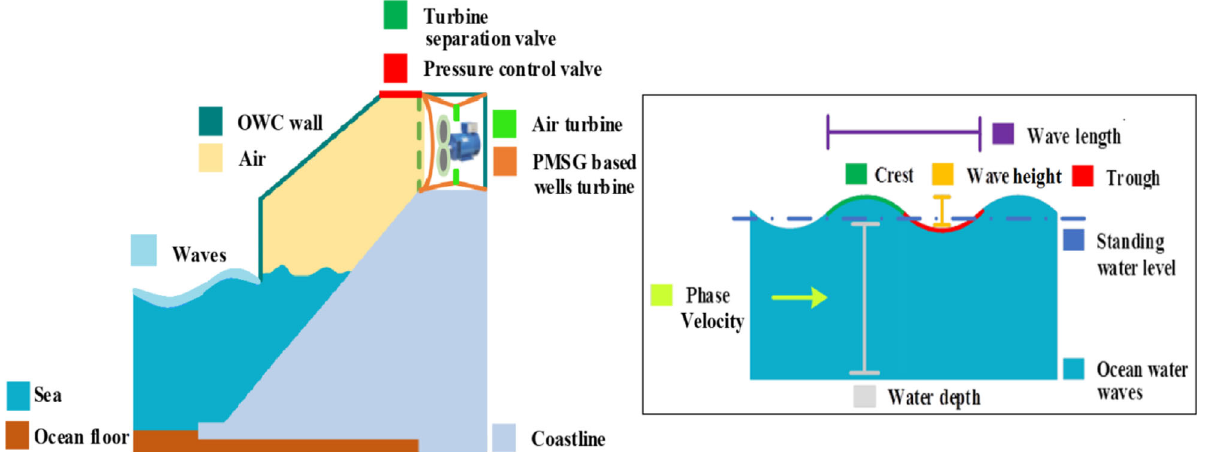
Fig. 1 Representation of ocean wave converter. a) OWC chamber layout. b) Ocean wave concept